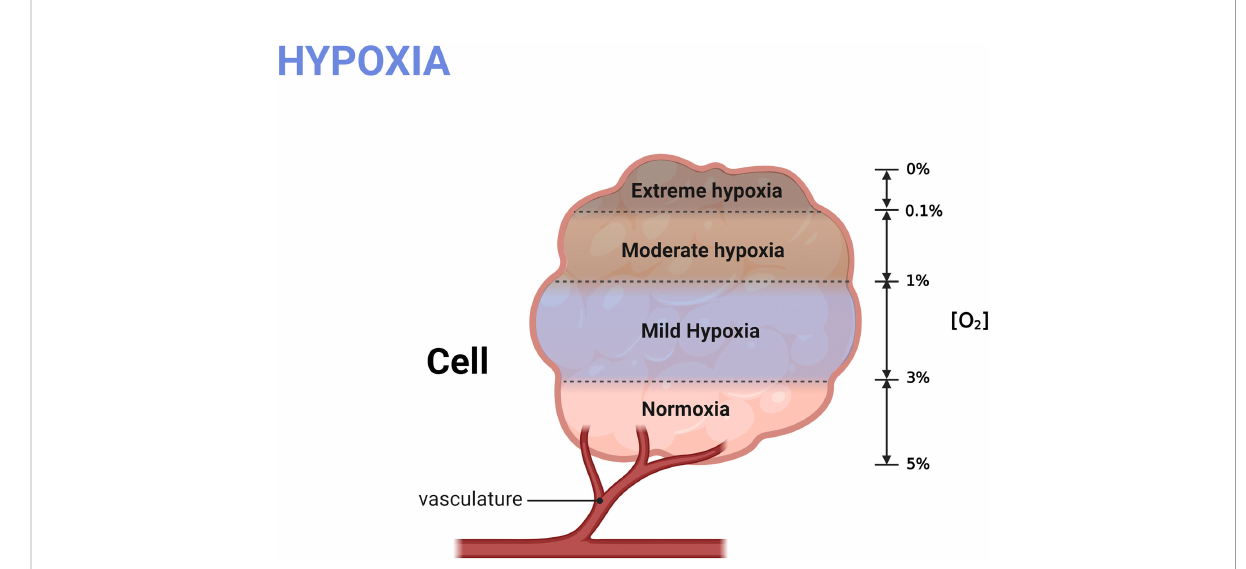
FIGURE 2 Grading of hypoxia. The normal oxygen content in human cell is 3%~5%; mild hypoxia refers to the oxygen concentration raging in 1%-3%; Oxygen content less than 1% is de fi ned as severe hypoxia. Created with